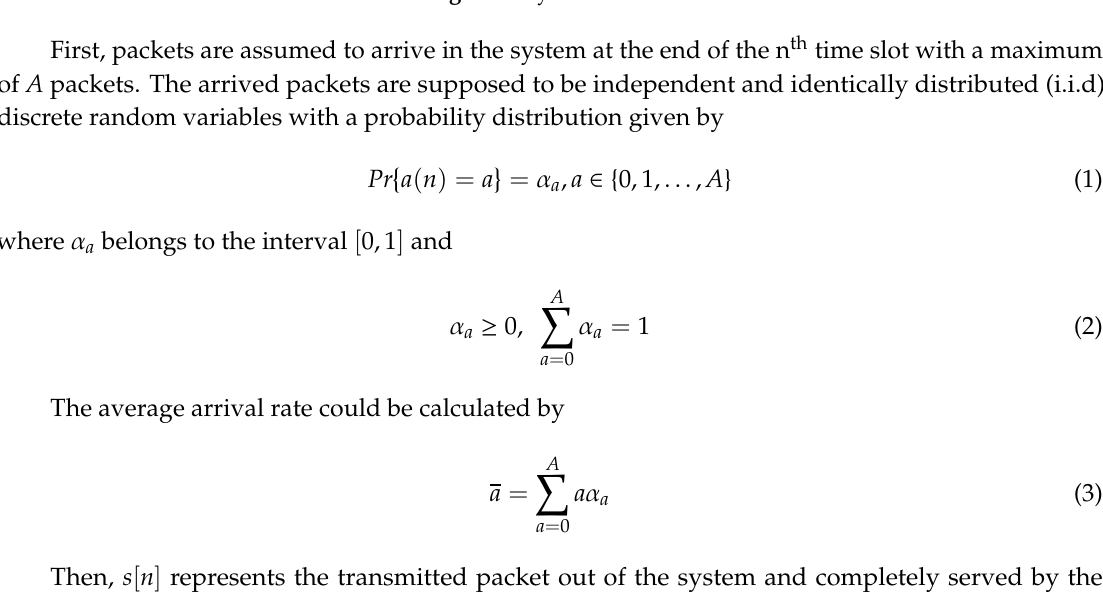
Figure 2. System model .